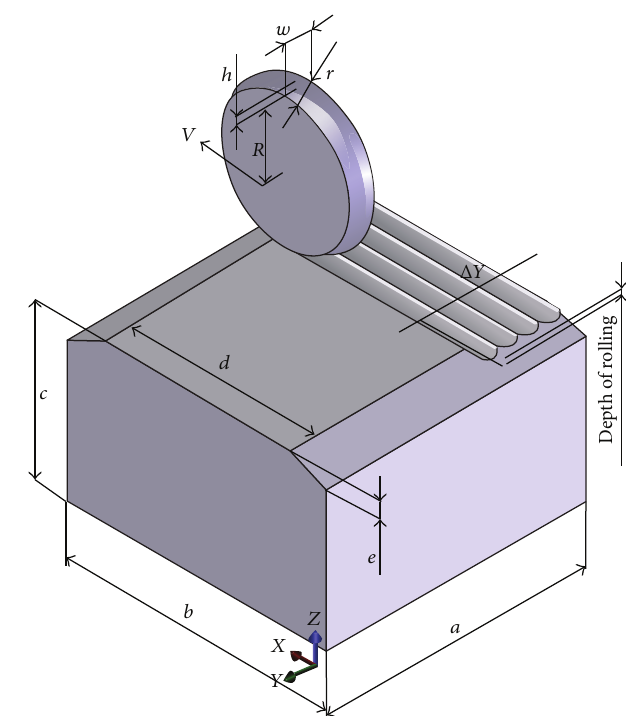
Figure 9: Residual stress profiles induced by DR in three directions [38].